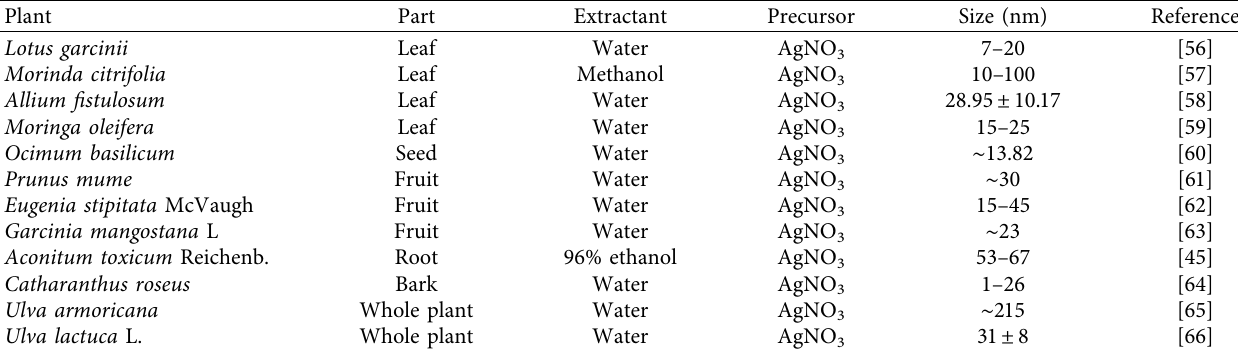
Figure 2: Schematic of the synthesis and application of metal nanoparticles by using plant extracts. Table 2: Representative examples for the use of plant extracts for AgNP